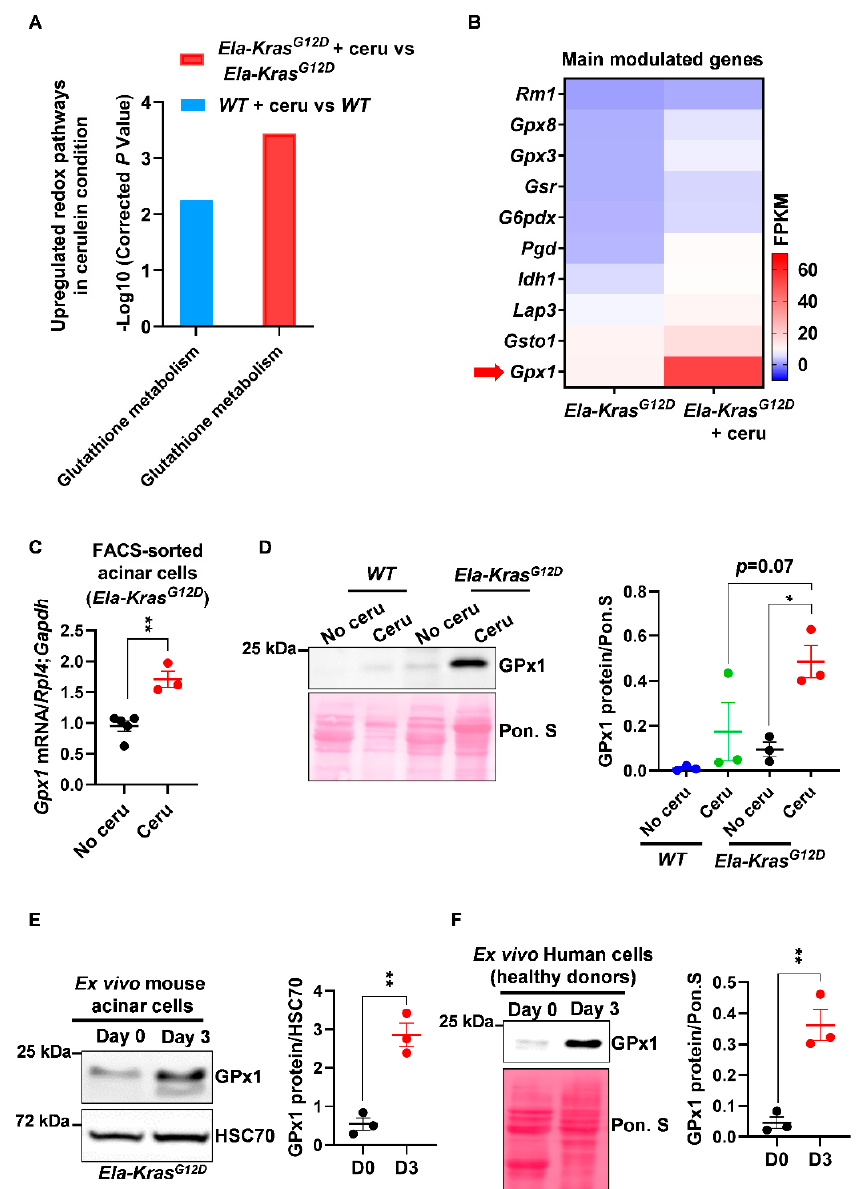
Figure 2. Pancreatitis modulates the expression of glutathione-regulating enzymes in mouse and human pancreatic cells. ( A ) Upregulated glutathione pathway identified by KEGG analysis in FACS-sorted acinar cells from wild-type ( WT) and Ela-Kras G12D mice treated with cerulein for 3 days ( n = 3 for both WT and Ela-Kras G12D ) or untreated ( n = 3 for both WT and Ela-Kras G12D ). “Glutathione metabolism” is the official term used in the KEGG database; it means that the expression of a set of genes involved in glutathione oxidation and/or reduction is being changed. The corrected P -values were presented as “-Log10” so that when the differential expression is higher, the P -value on graph follows the same tendency. ( B ) Heatmap for the main genes modulated in the glutathione metabolism pathway in Ela-Kras G12D mice treated with cerulein for 3 days ( n = 3) or untreated ( n = 3). Red arrow shows one of the most expressed genes, GPx1 . ( C ) Quantitative PCR for glutathione peroxidase 1 ( Gpx1 ) on FACS-sorted acinar cells from Ela-Kras G12D mice treated with cerulein for 3 days ( n = 3) or untreated ( n = 5). Ribosomal protein L4 ( Rpl4 ) and glyceraldehyde-3-phosphate dehydrogenase ( Gapdh ) were used as housekeeping genes. ( D ) Western blot for GPx1 on pancreas lysates of wild-type ( WT ) and Ela-Kras G12D mice treated with cerulein for 5 days ( n = 3 for both WT and Ela-Kras G12D ) or